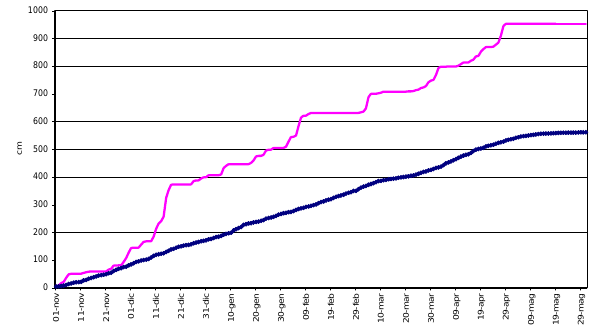
Fig. 2. The daily amount of new accumulated snow measured by Figure 2. The daily amount of new accumulated snow measured by mountain weather stations in mountain weather stations in winter 2008–2009 (pink line) and the winter 2008-2009 (pink line) and the 30 years climatology averaged over the western Alps (blue 30yr climatology averaged over the western Alps (blue line). line). As the snow in the mountain is concerned, see Fig. 3, the 2008-2009 winter has been characterized by a large amount of new snow with respect to the climate, with snow amount up to the 99% above the average. In three alpine sectors it has been the snowiest season since 1966.